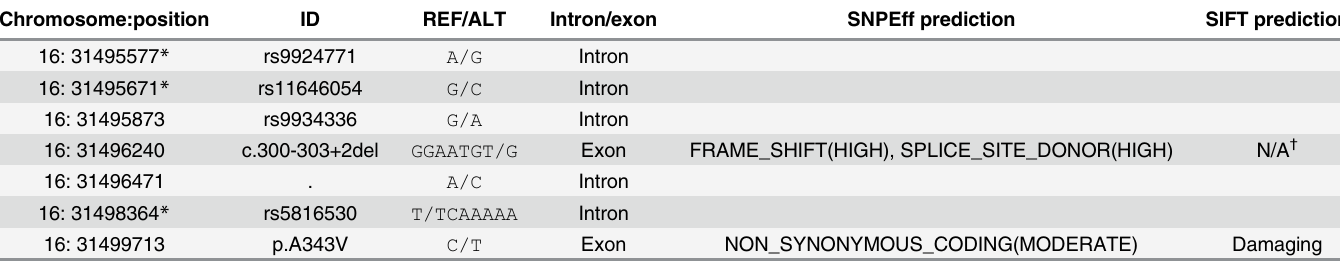
Table 1. Variants found in the SLC5A2 gene by whole exome sequencing of the family.